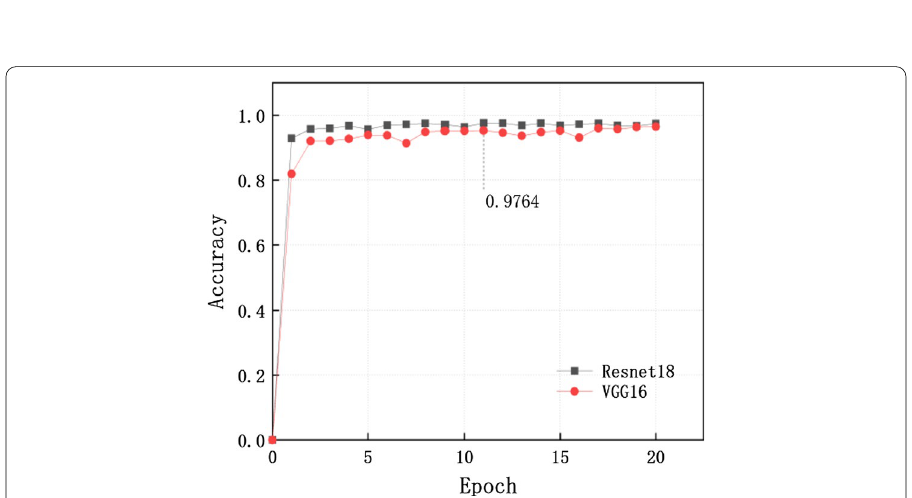
Fig. 16 The training process of Resnet18 and